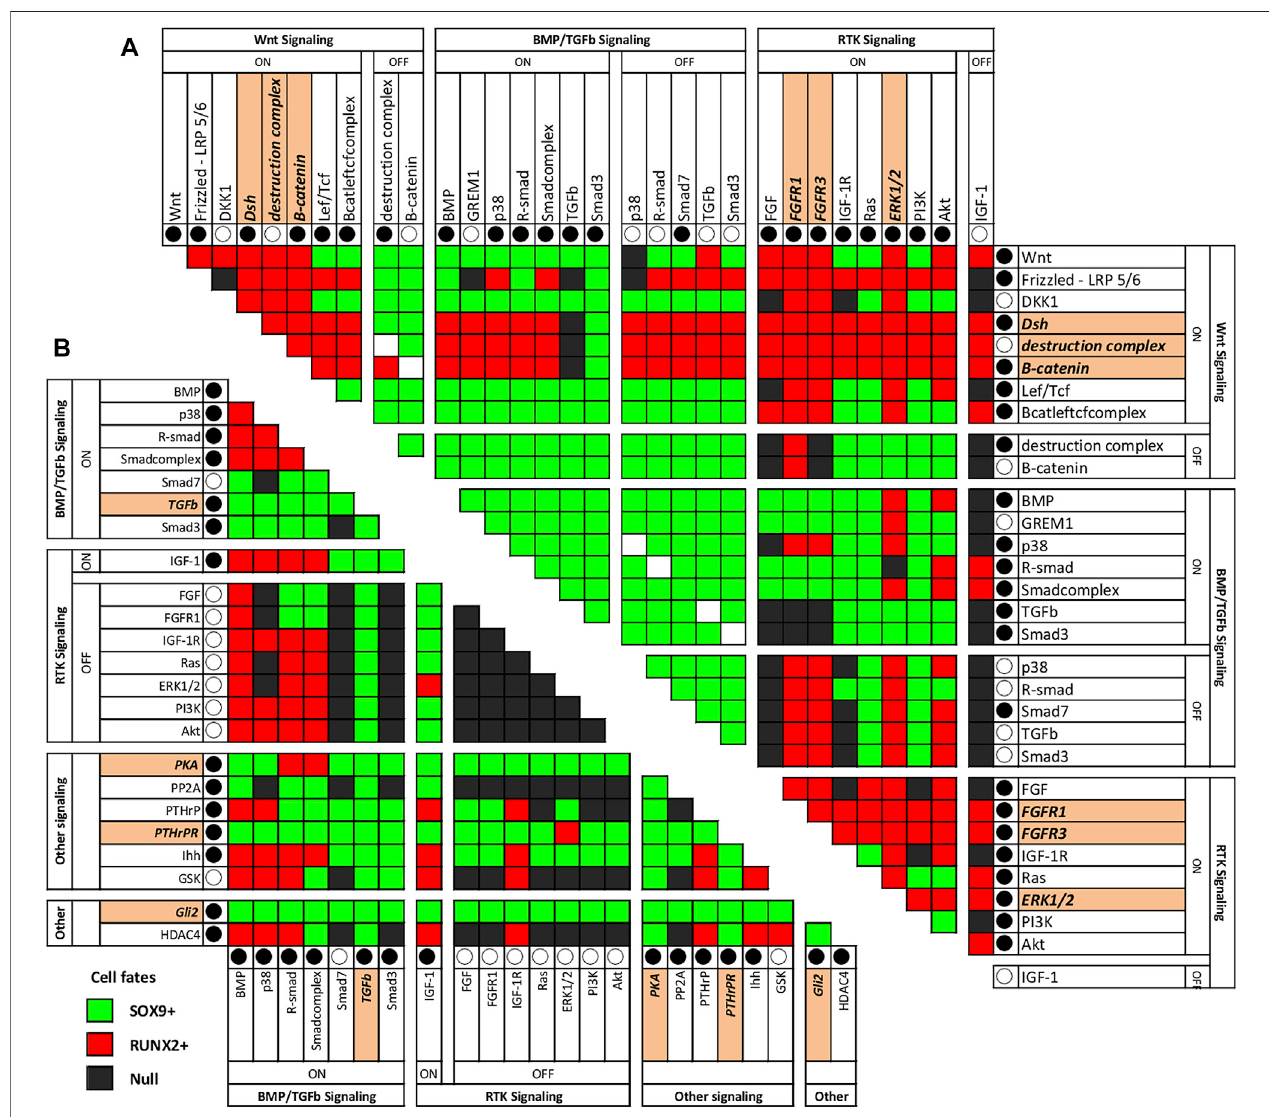
FIGURE 4 | Combination of perturbations that cause a SOX9+ to switch to a RUNX2+ state (A) or RUNX2 + state to switch to a SOX9 + state (B) in the AC model. This fi gureshowscombinationsofknockoutandoverexpressionthatinduceswitchesbetweentheRUNX2andSOX9positivestates. Anoverviewofallcombinationsof knockouts and overexpression can be found in the supplemental material. Each pair of nodes in the network was perturbed in all combinations of knock-out ( ○ ) and constitutive activation ( C ), while all other nodes were initialized as in the RUNX2 + state. After one simulation, the resulting stable state was recorded. Single node modi fi cations arehighlightedif they canbeused alone toobtaintheswitch. (A) Switch from SOX9 + toRUNX2 + , (B) Switch from RUNX2 + toSOX9 + .Theextended fi gure can be found in the Supplementary Figure S6 .